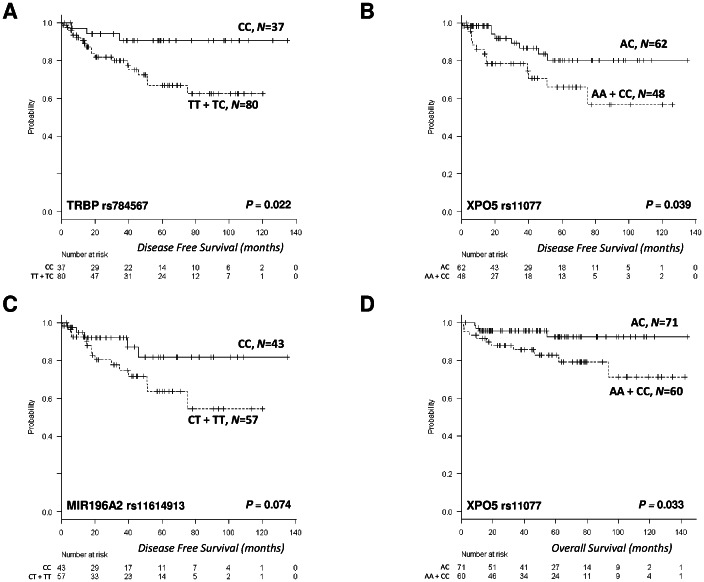
Clinical outcomes according to miR-SNPs.DFS according to TRBP, XPO5 and MIR196A2, and OS according to XPO5. (A) Mean DFS for 37 patients (31.6%) with the TRBP CC genotype was 124 months (95% CI, 112–136) vs. 86.8 months (95% CI, 74–89) for those with the TT or TC genotype (P = 0.022). (B) Mean DFS for 62 patients (56.3%) with the XPO5 AC genotype was 114.2 months (95% CI, 101–127) vs. 85.8 months (95% CI, 68–104) for patients with the AA or CC genotype (P = 0.039). (C) A trend towards an association between the MIR196A2 genotype and DFS was also observed; mean DFS was 115 months (95% CI, 99–131) for patients with the CC genotype, compared to 81 months (95% CI, 66–97) for those with the CT or TT genotype (P = 0.07). (D) Mean OS for 71 patients (54.2%) with the XPO5 AC genotype was 135.3 months (95% CI, 127–143) vs. 114.2 months (95% CI, 99–129) for those with the AA or CC genotype (P = 0.033).